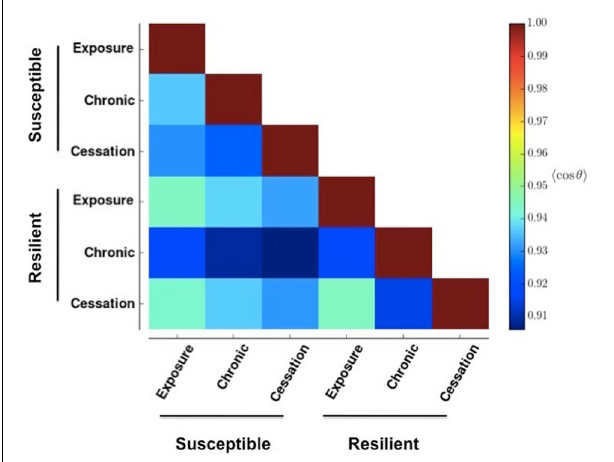
FIGURE 4 | Similarity between network activities in Figure 3. The color of each box in the heat map shows the circular mean of the cosine of the angles formed between each row of the corresponding panels in Figure 3 . A row makes an angle of 0 with itself, which corresponds to a cosine value of 1. Cooler colors indicate more different patterns.